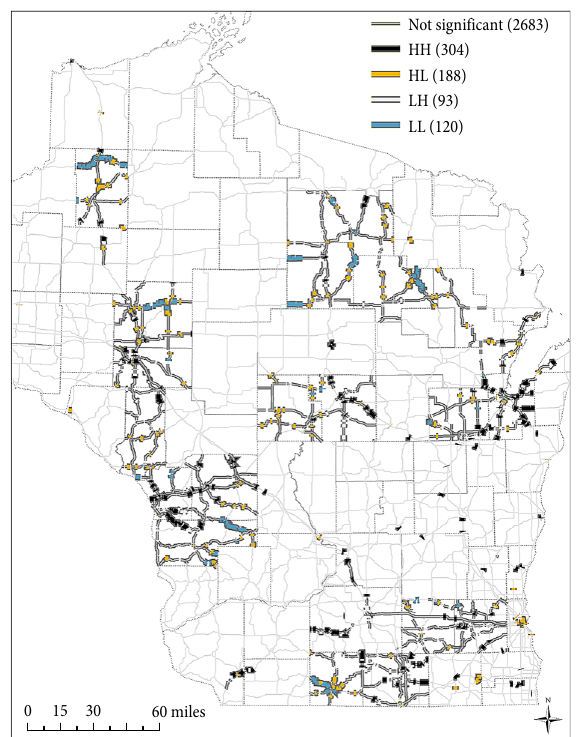
Fig. 3. Contiguous MM segments of Wisconsin STN roads for targeted pavement friction data collection (including Local Moran’s I hotspots of weather-related crashes)